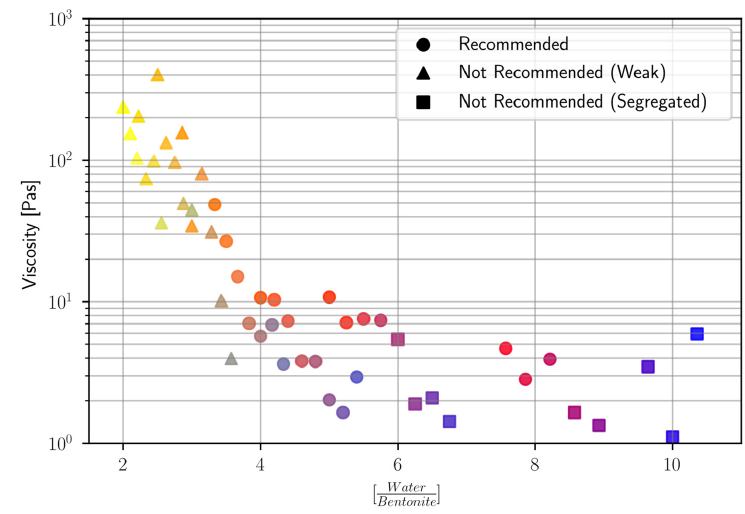
Figure 13. Viscosity vs. water/bentonite ratio.